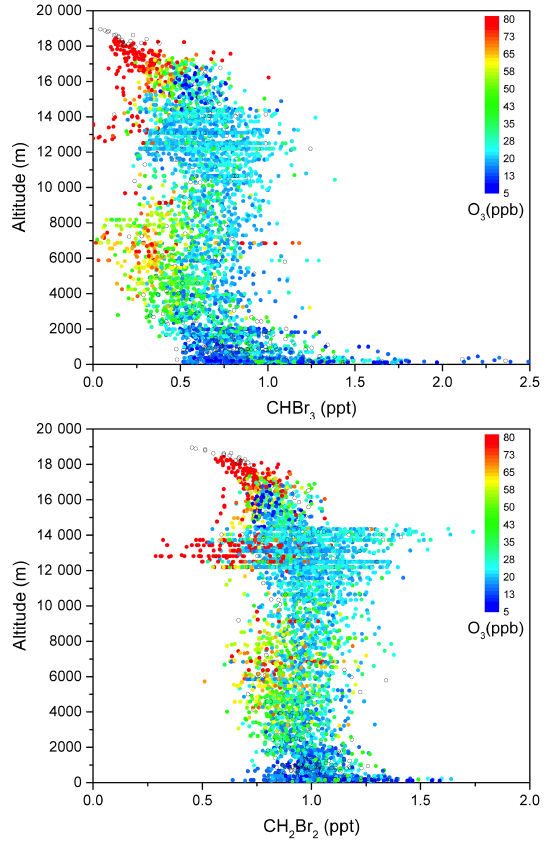
Figure 6. Vertical profiles of CHBr 3 (top) and CH 2 Br 2 (bottom) combined datasets, coloured by ozone concentration. Empty circles depict measurements with no corresponding ozone measurement.